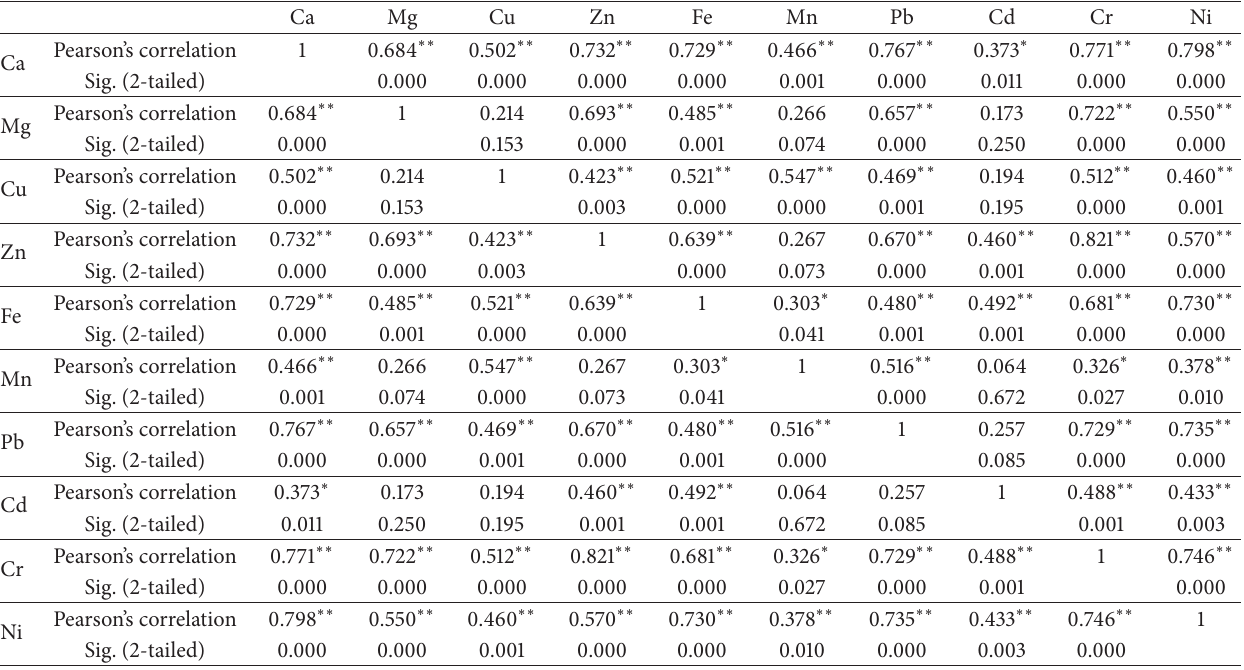
Table 3: Correlation coefficients of the mineral